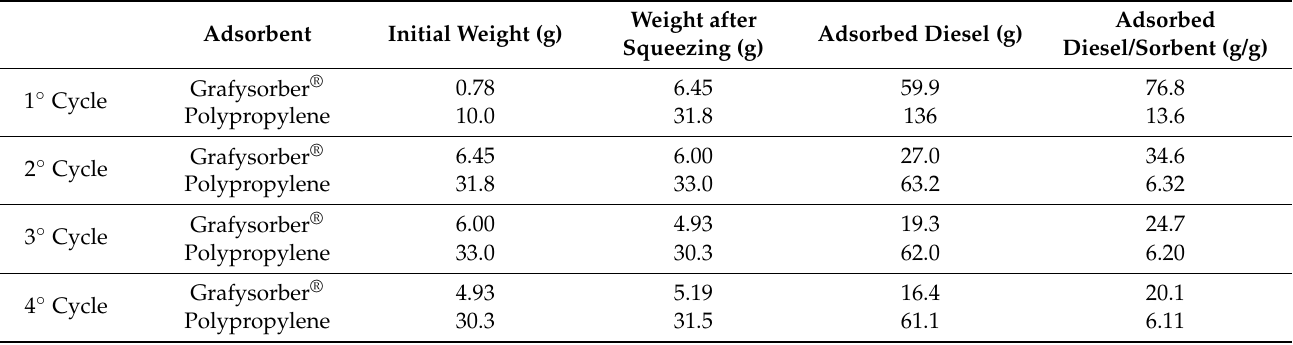
Table 3. Diesel adsorption tests with Grafysorber ® G+ and Polypropylene.